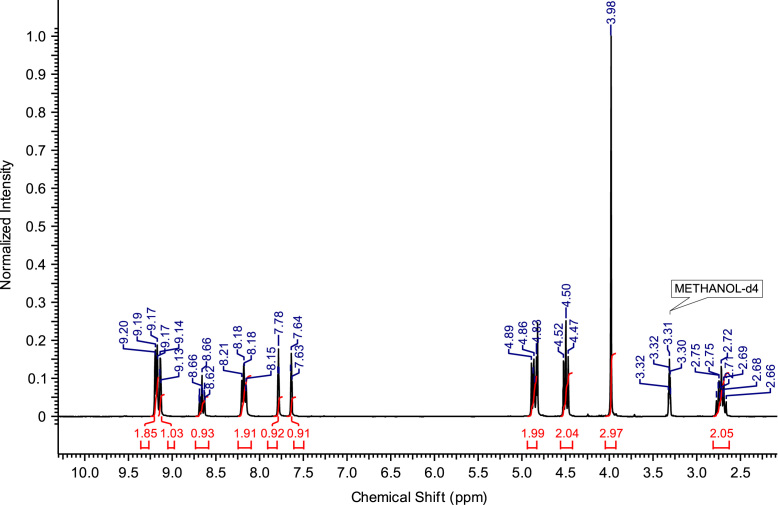
1H NMR spectra of C3(Pyr)(MIm)Br2.